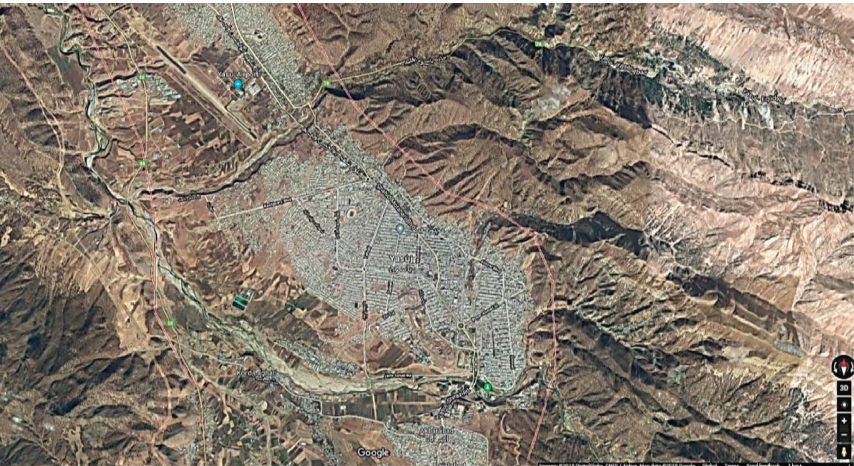
Figure 1: The study area near the city of Yasuj.